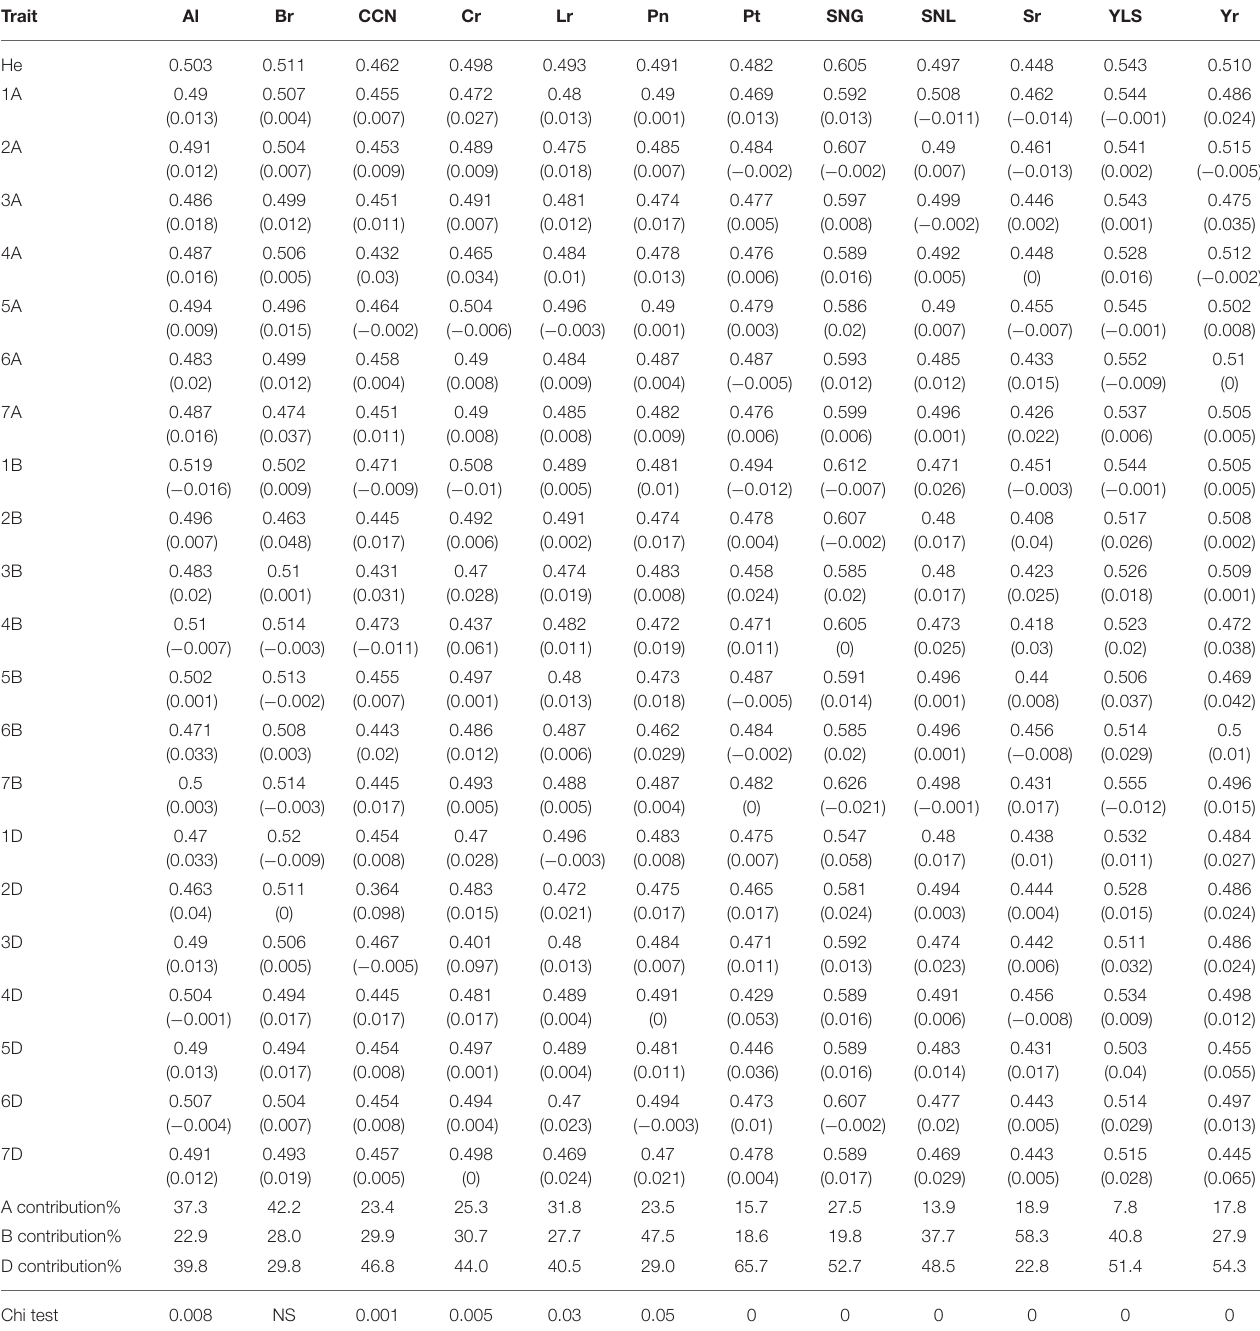
TABLE 3 | The heritability estimation using the conditional effect model (excluding the GRM of one chromosome).